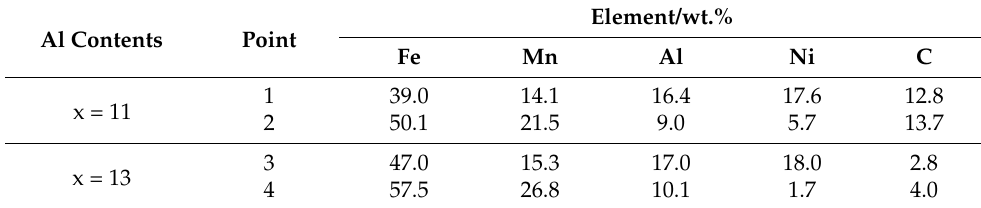
Figure 3. SEM photograph of Fe-25Mn- x Al-8Ni-C alloy ( a ) 10 wt.% Al; ( b ) 11 wt.% Al; ( c ) 12 wt.% Al; ( d ) 13 wt.% Al. Table 1. EDS analysis of Fe-25Mn- x Al-8Ni-C alloy in Figure